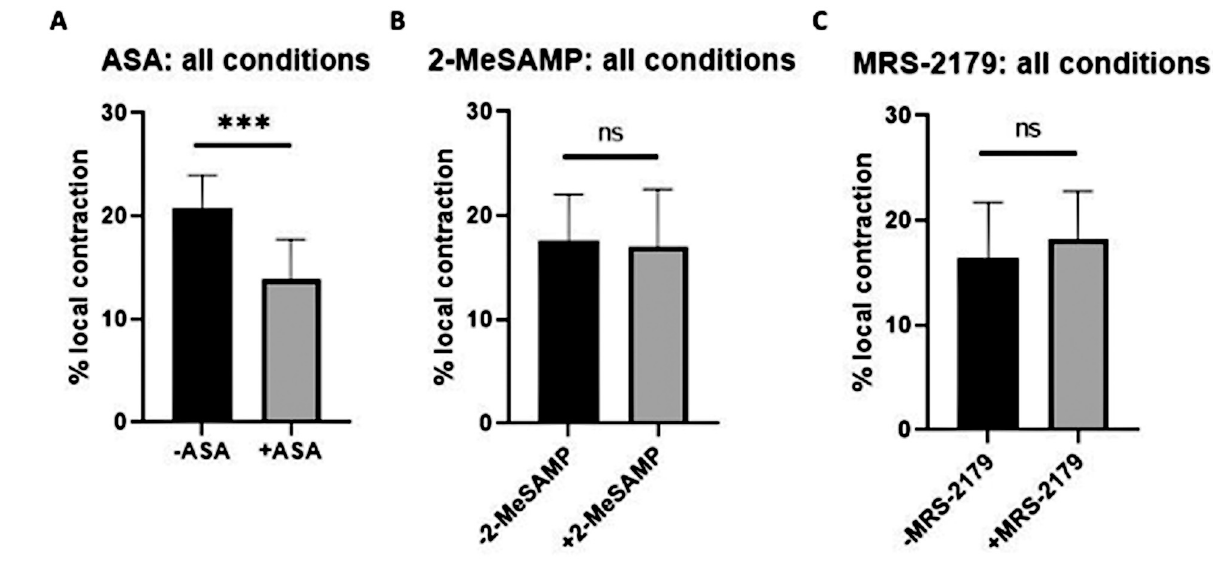
Fig. 5 ASA limits local platelet contraction, while 2-methylthio (Me)-SAMP and MRS-2179 have no effect. We performed a meta-analysis of data from ► Fig. 3B by segregating data into different component conditions. Each of the 4 conditions with ASA and each of the 4 conditions without ASA were averaged and compared (A); the same was done for 2-methylthio (Me)-SAMP (B) and MRS-2179 (C). (N ¼ 3 donors, n ¼ 24 clots for each panel; (cid:5) p < 0.05, (cid:5)(cid:5) p < 0.01, (cid:5)(cid:5)(cid:5) p < 0.001). ASA, acetylsalicylic acid. TH Open Vol. 00 No. 0/2022 © 2022. The